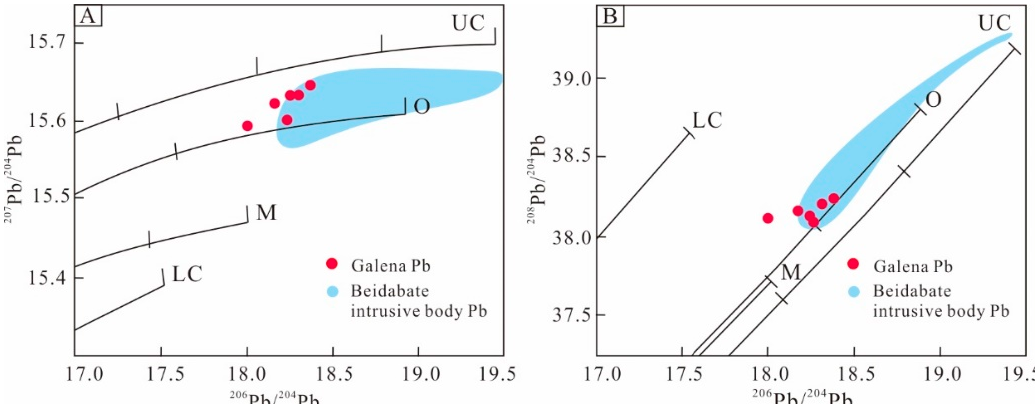
Figure 10. Lead isotope compositions for sulfides in the Kuergasheng Pb–Zn deposit. ( A ) 207 Pb/ 204 Pb vs. 206 Pb/ 204 Pb plot. ( B ) 208 Pb/ 204 Pb vs. 206 Pb/ 204 Pb plot. The average growth curve is from Zartman and Doe [45]. Abbreviations: UC—upper crust; LC—lower crust; O—orogenic; M—mantle. Pb isoplot data of the Beidabate intrusive body are from Li [43].